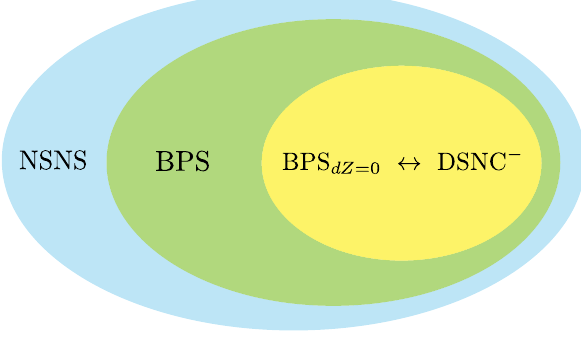
Figure 3 . A schematic depiction of the types of solutions considered in this section. The blue outline represents all the solutions of pure NS gravity. The green outline represents the solutions that preserve at least one supercharge. This implies that the solution has a lightlike Killing vector [32]. The yellow outline denotes the solutions of N = (1 , 0) 0 supergravity, i.e. those that can be mapped to solutions of the DSNC − supergravity theory. The boundary between the green and the yellow solutions is delineated by the constraint